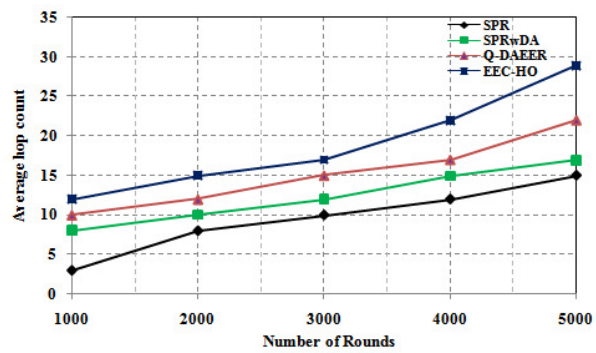
Figure 9. Average hop count with number of simulation rounds